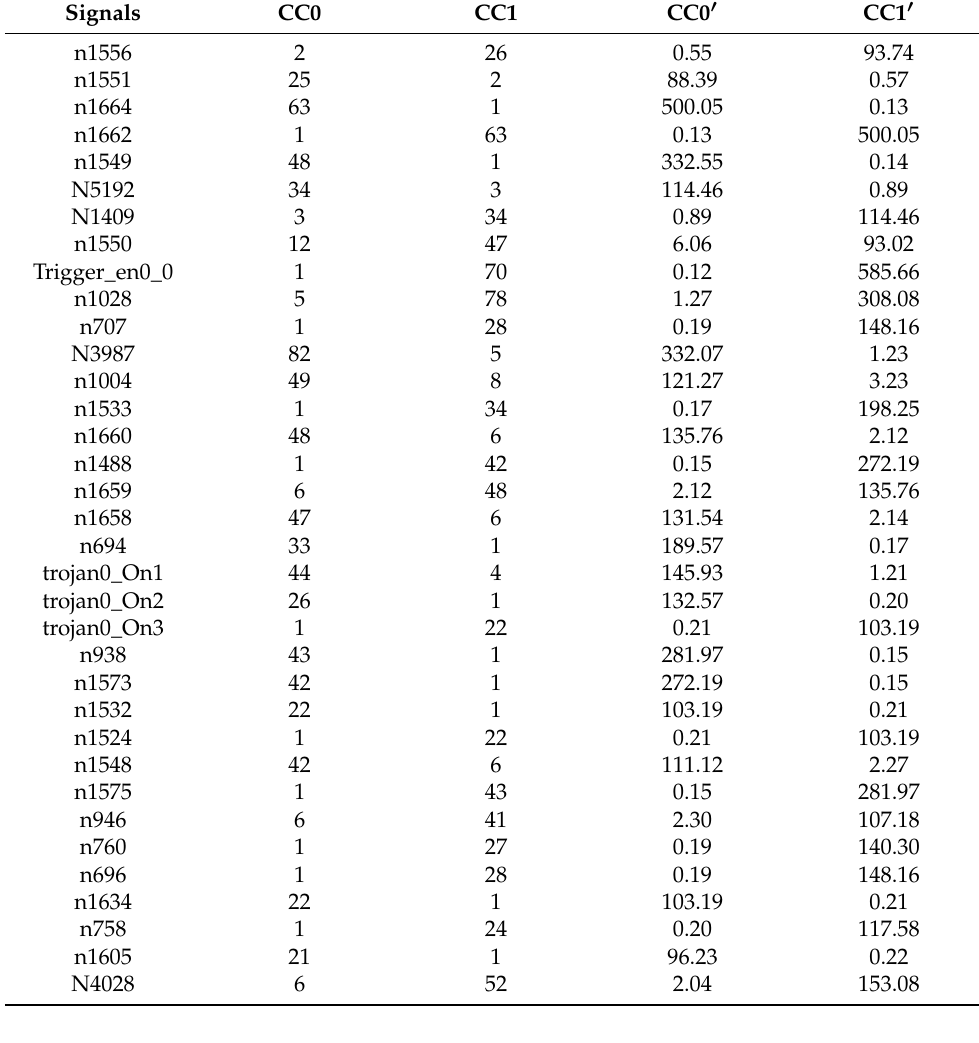
Table 1. Suspicious signals of c3540_T000.